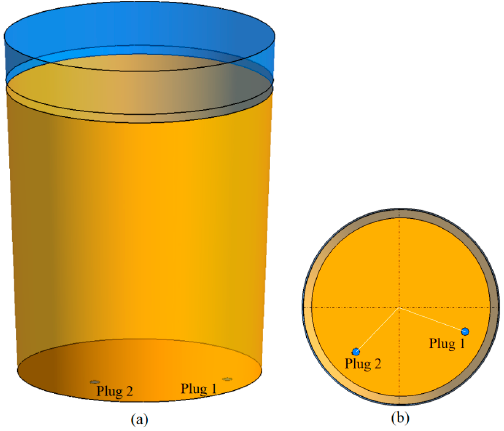
Figure 2. Geometry model and boundary conditions: ( a ) isometric view, ( b ) top view.